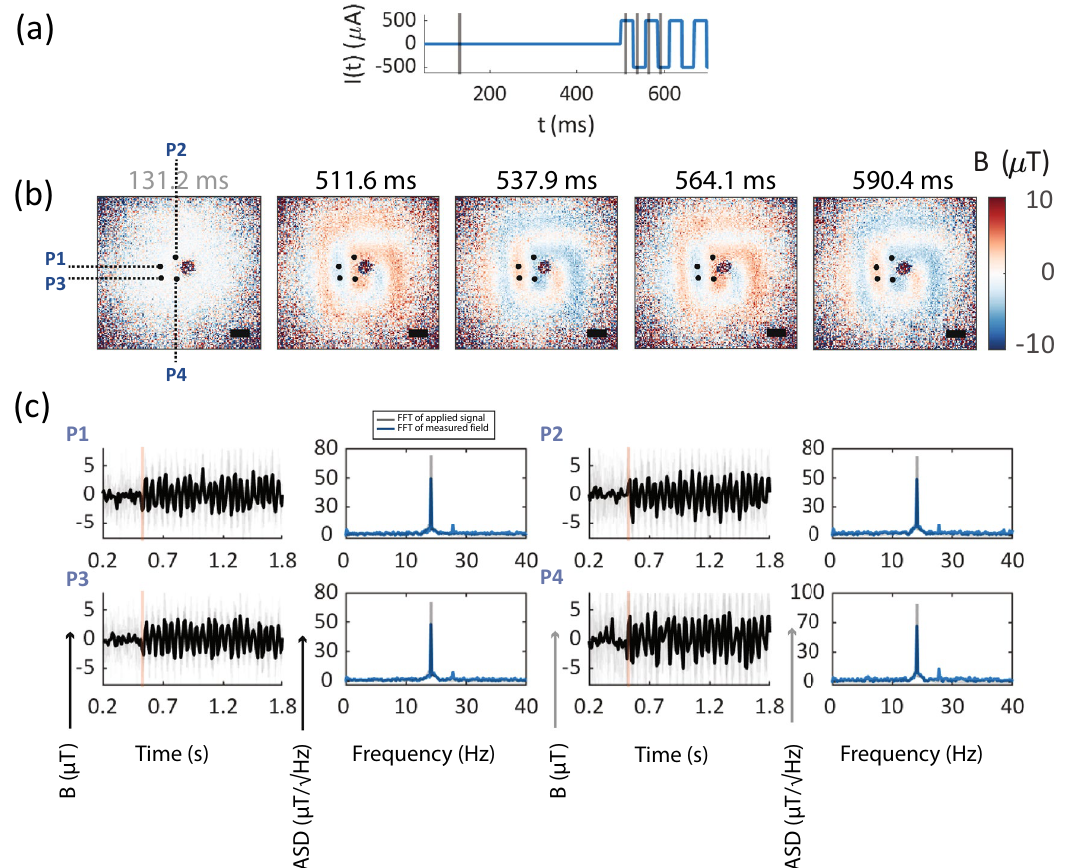
Figure 6. Temporal imaging of 17.9 Hz magnetic field variation at 78 frames per second of the microcoil sample: ( a ) Applied current waveform (blue line) to the microcoil sample. Black vertical lines mark example timepoints at which single magnetic field frames have been shown. Only few initial example periodic cycles of 15 the applied current waveform have been shown. ( b ) Magnetic field frames at single time points (averaged n = iterations) showing alternating field image contrast with reversal in current direction. No voltage applied for a baseline time of 0.5 s, first frame selected from baseline window. A periodic square wave voltage waveform of alternating polarity was applied after the baseline time, at 17.9 Hz periodicity and peak current 500 µ A . Exact magnetic field frame time points have been shown on top of each image. Scale bar 34 µ m ( c ) Full temporal time traces of example pixels showing magnetic field tracking in time. Location of example pixels, labelled P1–P4 in the field of view have been shown in the magnetic field images. For each pixel, magnetic field traces versus time show tracking of applied the magnetic field, with faded gray lines as single iteration traces and solid black 15 ) magnetic field traces for the pixel. Amplitude spectral density of single-pixel field lines showing mean ( n = traces are shown on the left, where pixel Fourier spectra are in blue and applied voltage Fourier spectra has been shown in gray. Applied voltage spectral density is scaled to a constant to compare spectral content with pixel Fourier spectra. Since pixels track magnetic field, the prominent peak in the pixel Fourier spectra matches with the peak in the Fourier spectrum of the applied voltage, both occurring at magnetic field variation 17.9